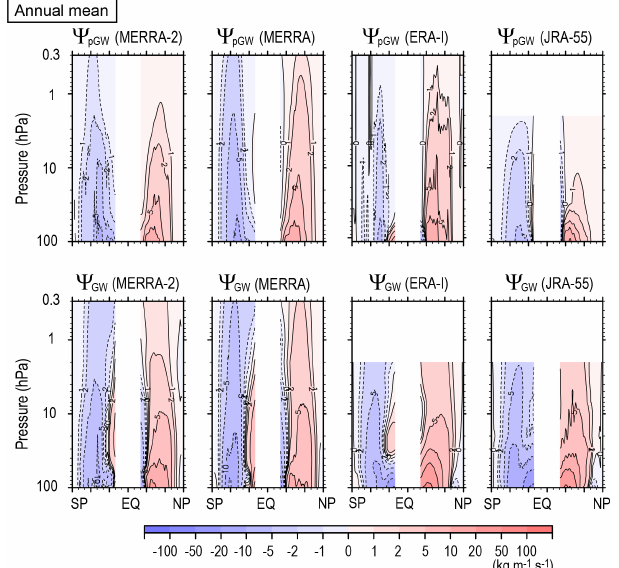
Figure 14. The same as Fig. 13 but for